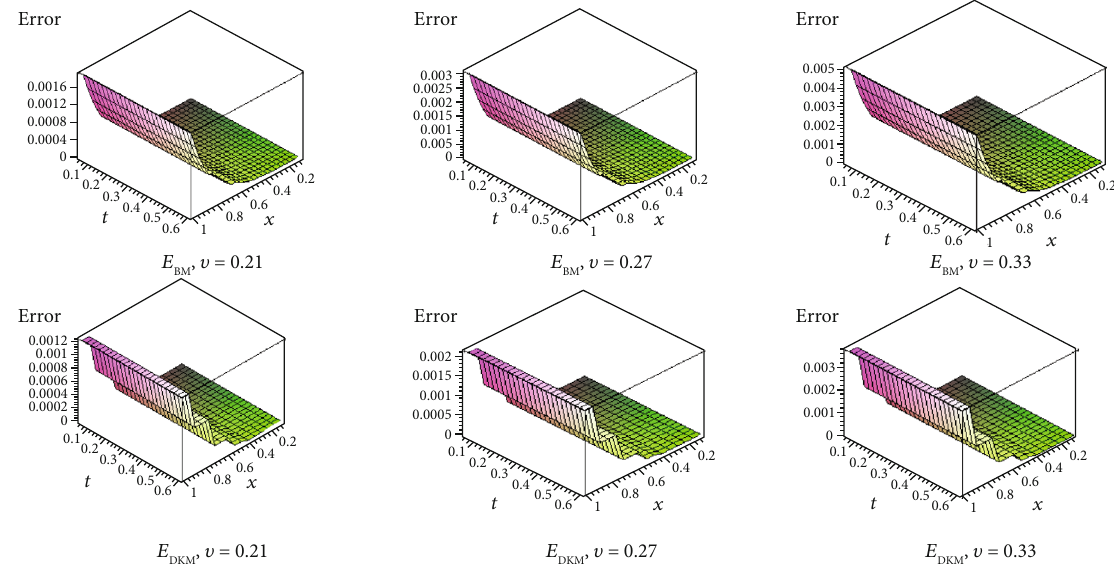
Figure 5: The values of errors by B-by-BM and DKM at T = 0 : 6 , N = 20 , and k = 1 for υ = 0 : 21, 0 : 27, 0 : 33 .